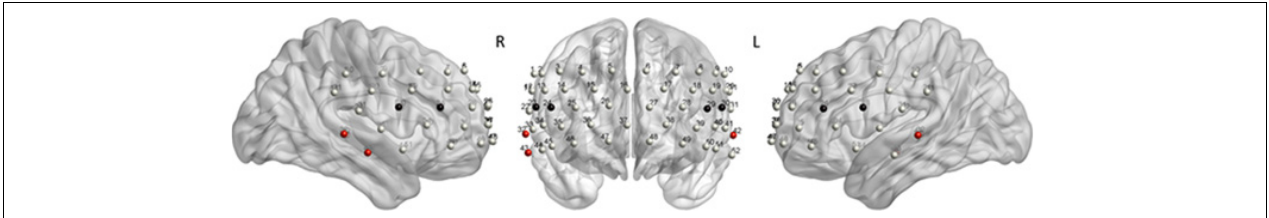
Shown are t-test comparisons assessing between-groups-differences (PA, PS, PA-PS compared to CO) of the delta lines, separately for RT and RT slow . Significant effects (p < 0.05) were highlighted (bold font).